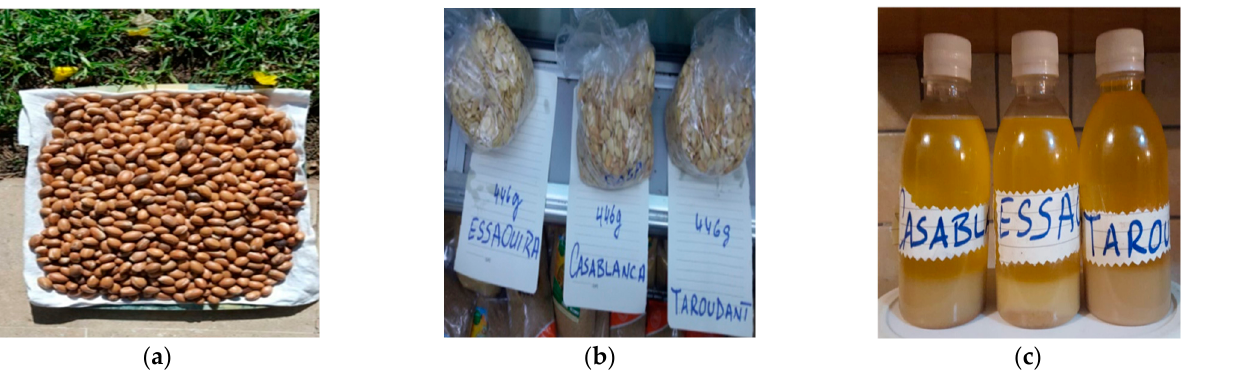
Figure 1. Sampling and extraction of argan oil from the plantation and two natural forest stands of argan trees. ( a ) Argan nuts from a plantation in Casablanca. ( b ) Composite samples of argan kernels collected from the three sampling sites (Essaouira, Casablanca, and Taroudant). ( c ) Argan oil ex- tracted by cold mechanical pressure.